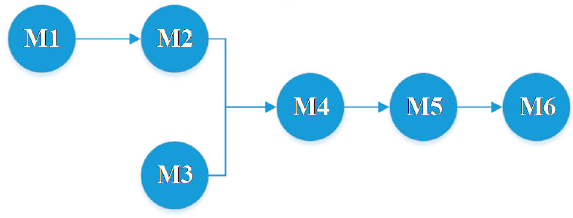
Figure 1. The illustration of the flow shop.